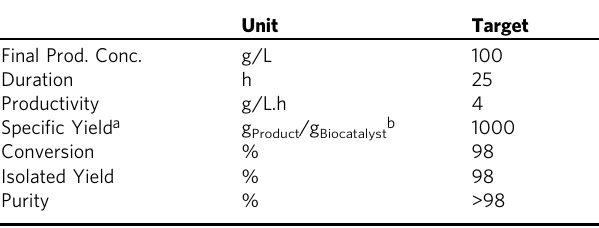
Table 1 Target proof of principle reaction metrics for oxidation of HMF to DFF by GOase.